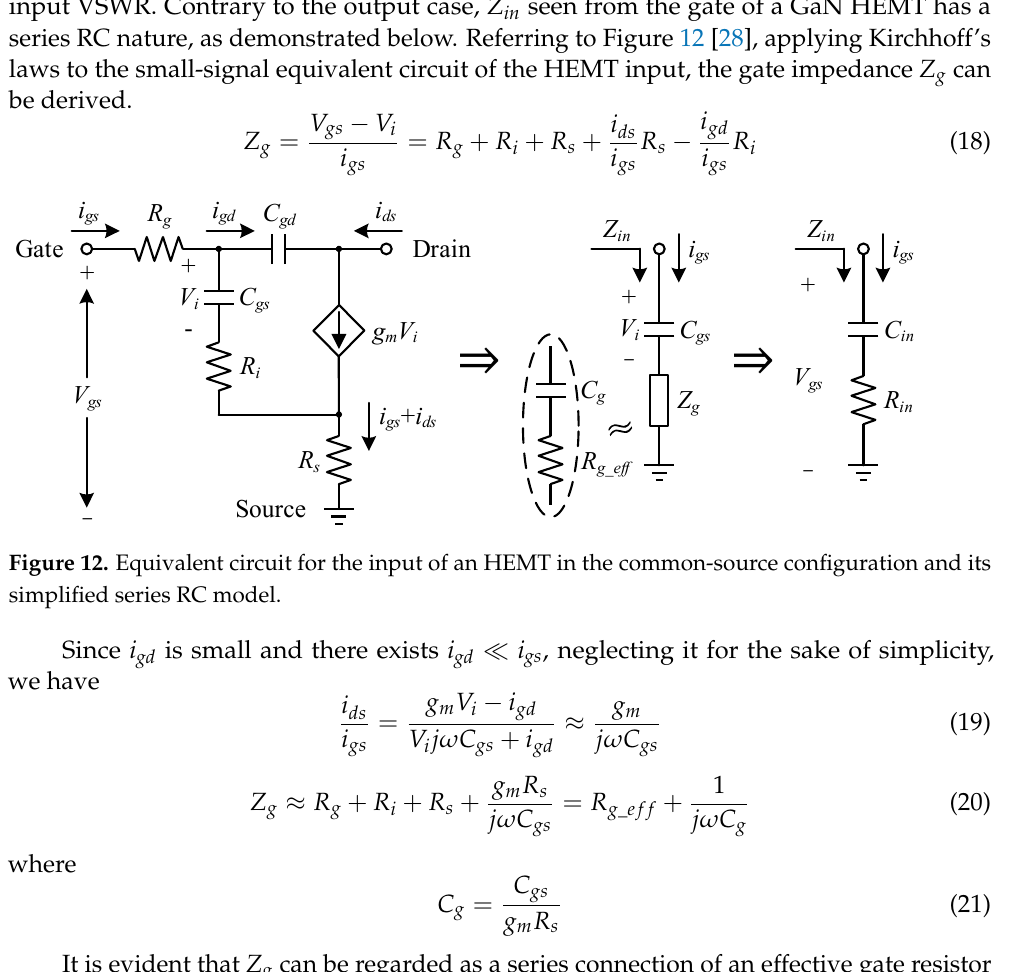
Figure 13. Input impedance characteristics of the stabilized 46 × 4 μ m cell and the series RLC equiv- alent circuit.